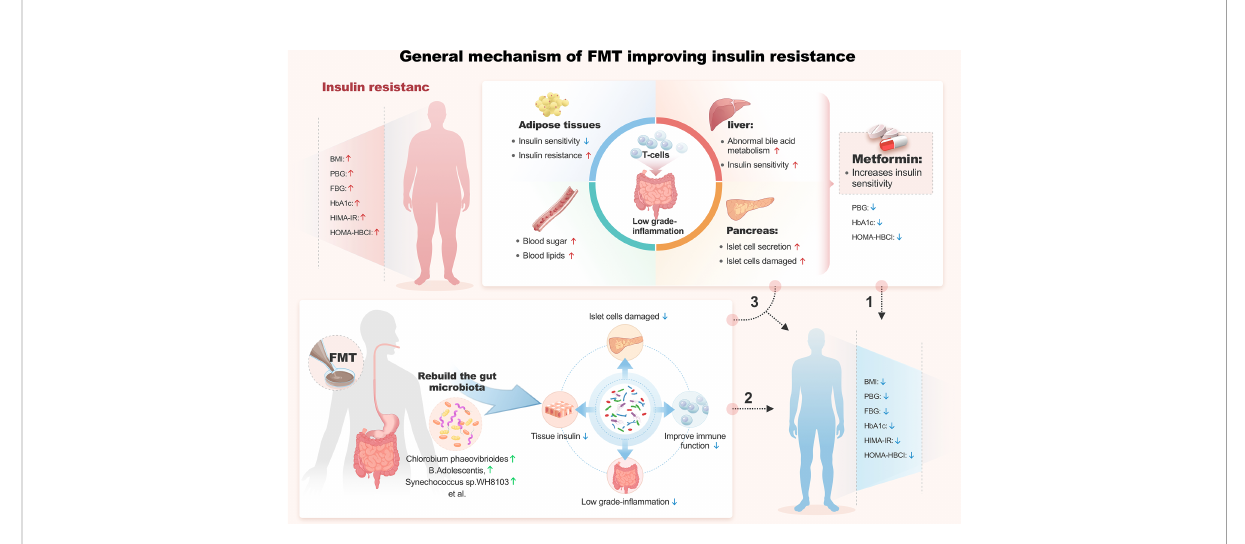
FIGURE 2 General mechanism of FMT improving insulin